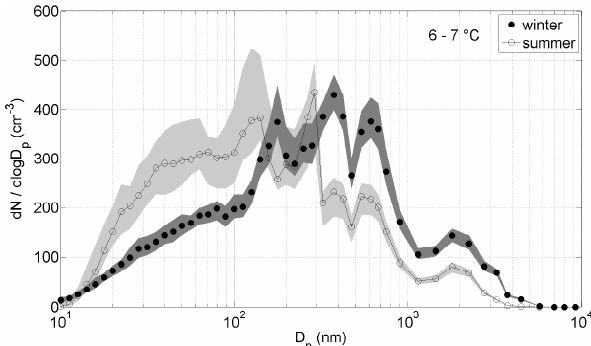
Fig. 6. Comparison of particle number size distributions resulting from deep sea water during summertime and wintertime, for the same water temperature ranges of 6–7 ◦ C. Grey shaded areas repre- sent the interquartile